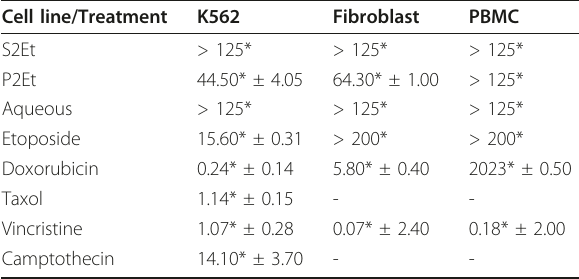
Table 2 IC 50 values of C.spinosa fractions and drugs in tumor cell lines and normal cells (gingival fibroblasts and PBMC) estimated using the MTT assay.